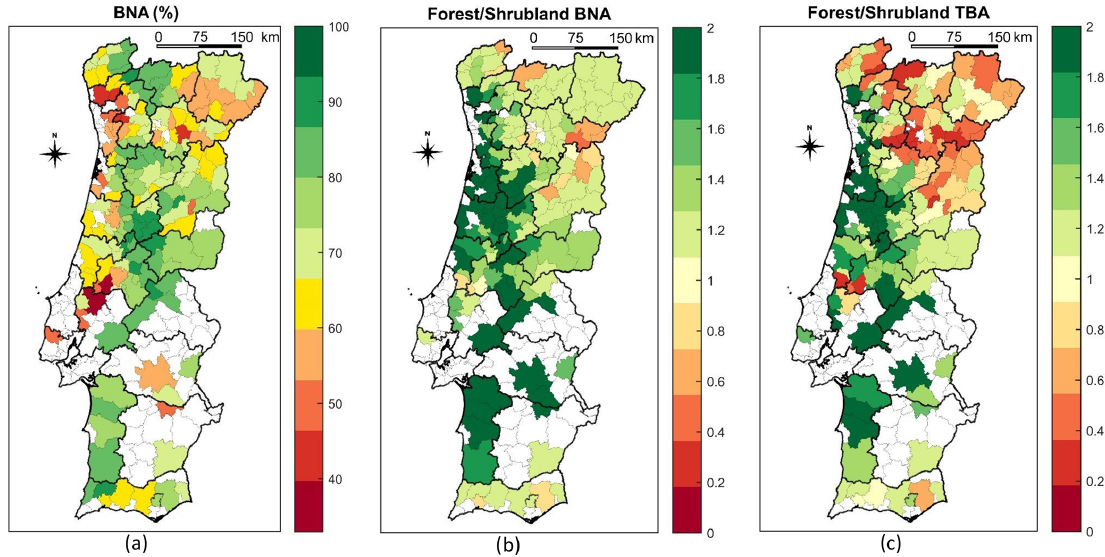
Figure 10. (a) Burnable area (BNA) in percentage; (b) forest / shrubland burnable area (BNAF / BNAS) and (c) forest / shrubland total burnt area (TBAF / TBAS); all during the period 2001–2019 for the selected